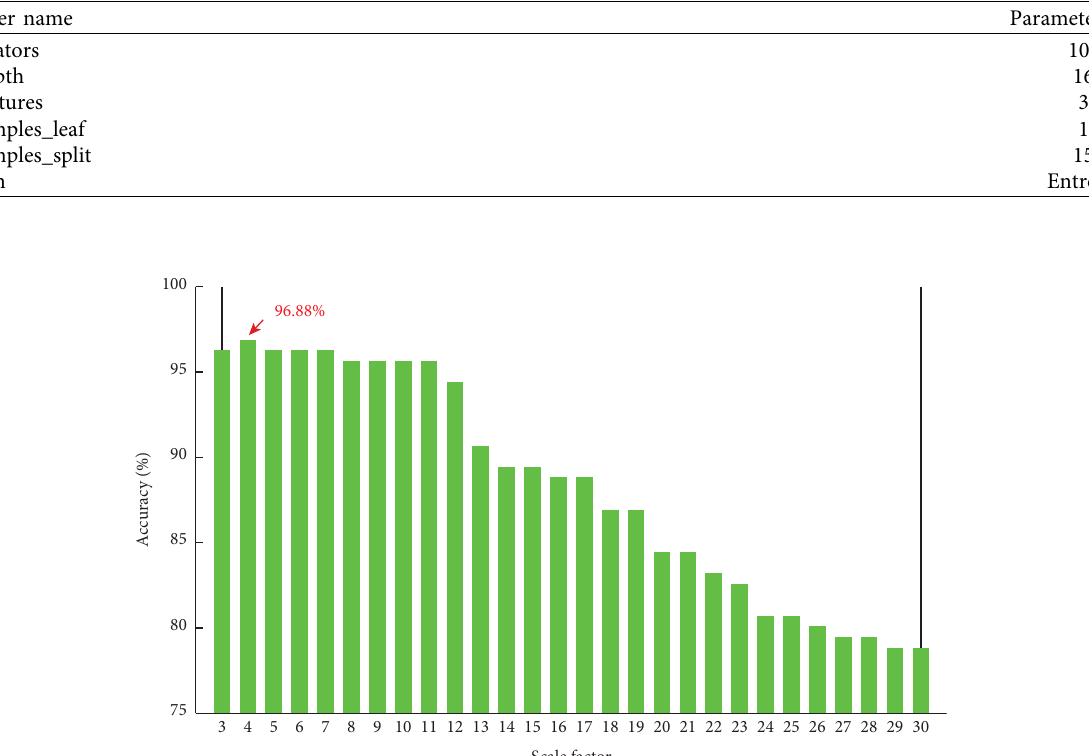
Table 3: Te parameters setting of RF